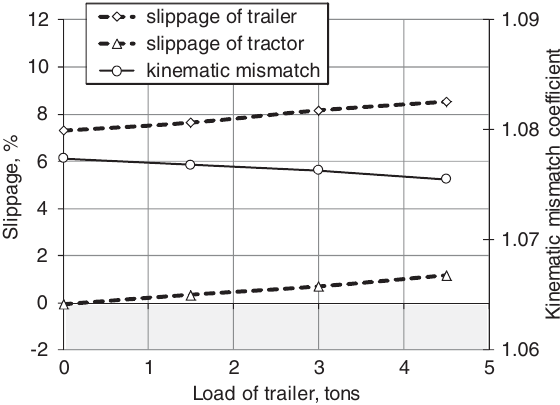
Fig. 8. The dependences of driving wheels’ slippage and kinematic mismatch coefficient on the load carried in the trailer, when tractor’s rear and trailer’s front driving axles are enabled and driving is executed on the tracks made by